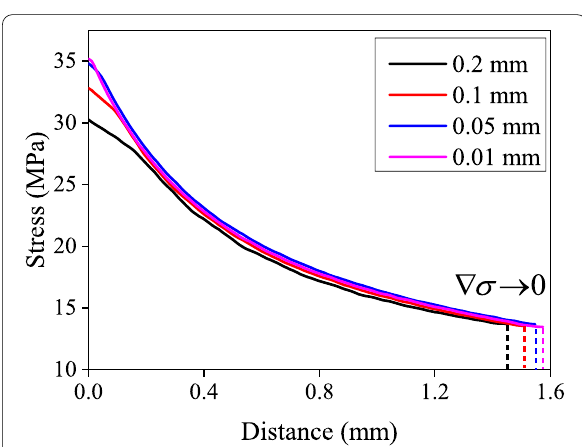
Figure 11 Stress distribution along the defined integral